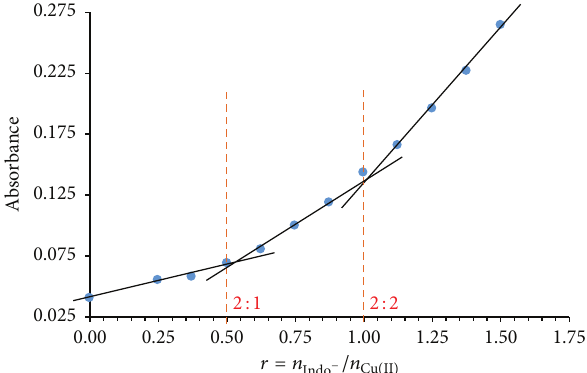
Figure 4: 𝐴 705 = 𝑓(𝑟) graph: intersections of straight lines are given in values of 𝑟 equal to 0.5 and 1.0 that correspond to the Cu 2 Indo 3+ and Cu 2 Indo 22+ complexes, respectively.